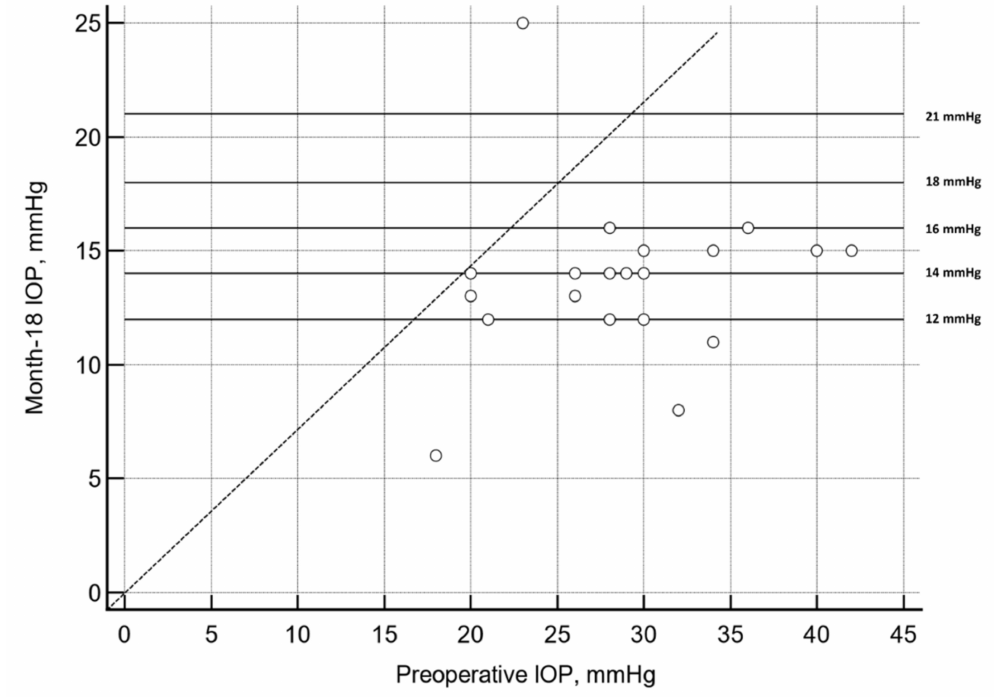
Figure 2. Scatter plot of the preoperative and month 18 intraocular pressure (IOP) (mean differ- ence − 12.9 mmHg; 95 CI: − 16.9 to − 8.9 mmHg; p < 0.0001, repeated measures ANOVA and the Greenhouse–Geisser correction